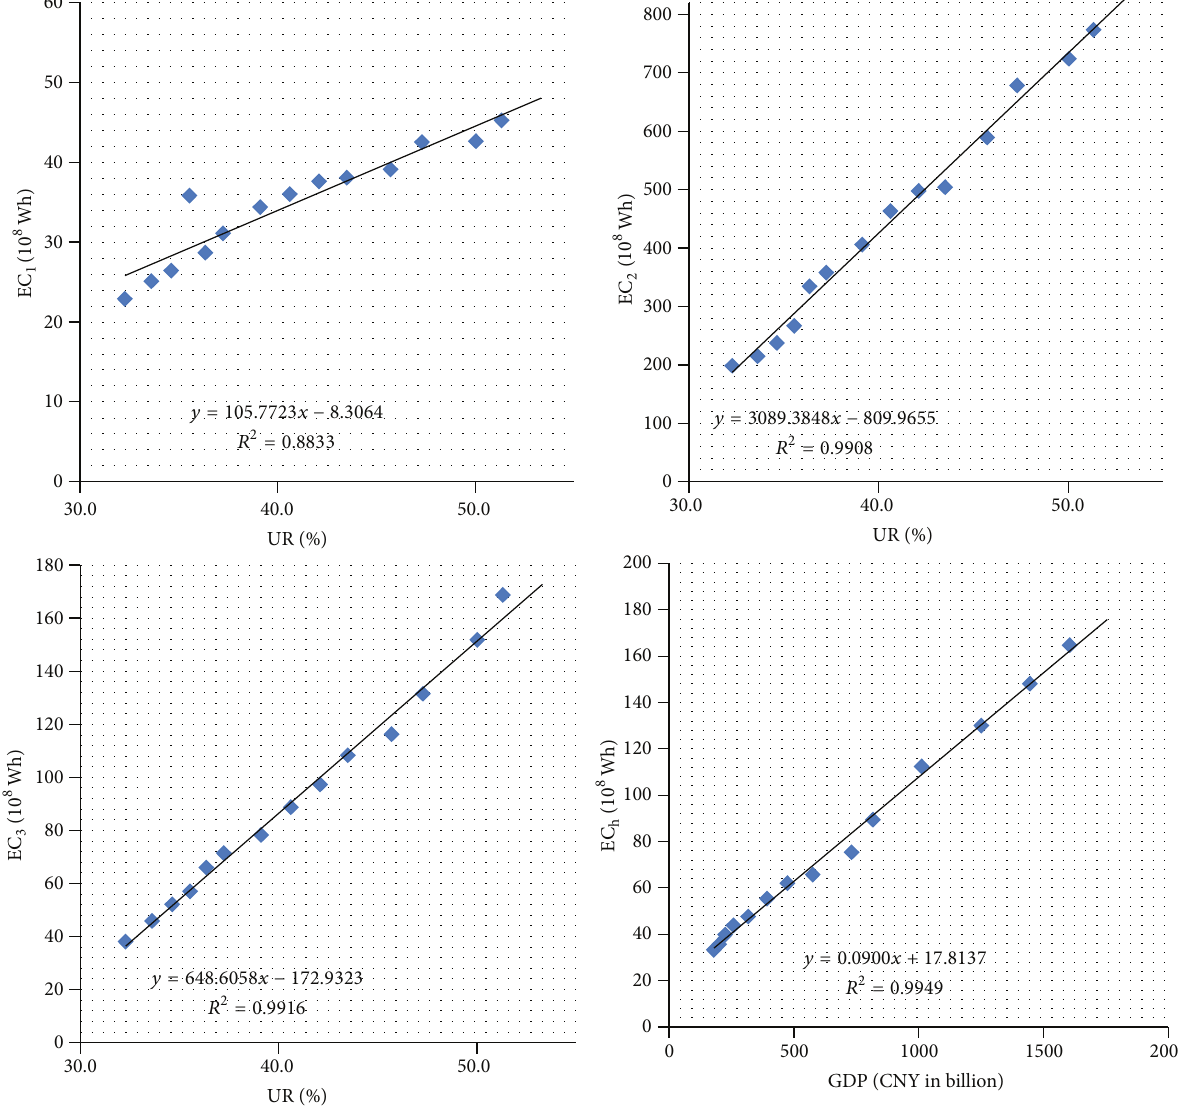
Figure 7: Linear regression results of four parts of EC in model (iv). EC 1